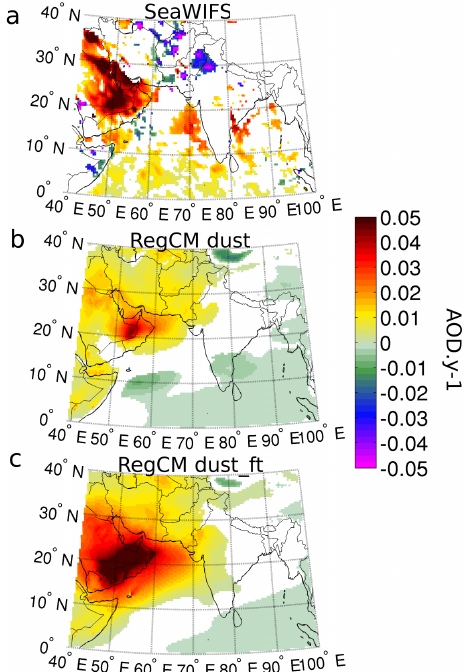
period from (a) SeaWIFS monthly observations, (b) model stan- dard dust simulations and (d) model dust _ ft simulations including a forced emission trend over the Arabian Peninsula. Only statistically significant trends ( p value < 0.05) are represented (cf. Sect. 2). All modeling results represent a three-ensemble-member